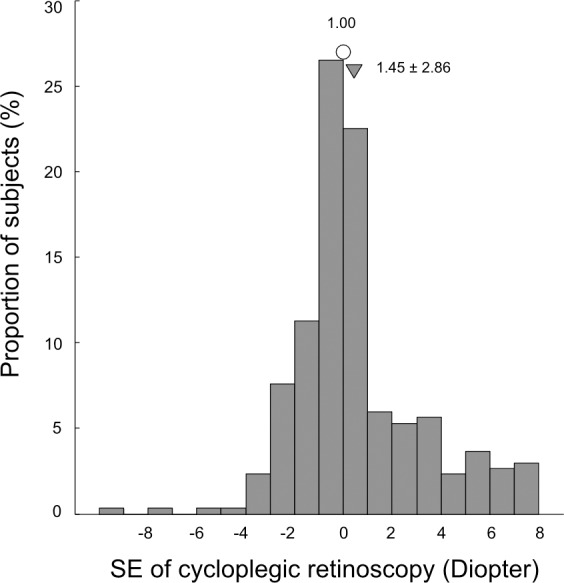
Histogram illustrating the distribution of spherical equivalent.